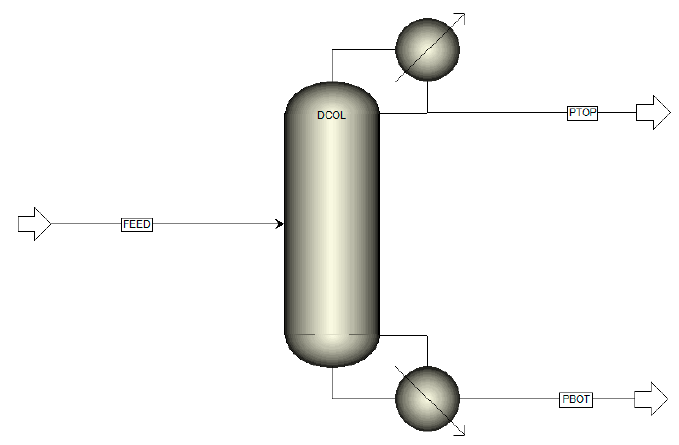
Figure 1. Schematic representation of the CDC model in Aspen Plus ® .